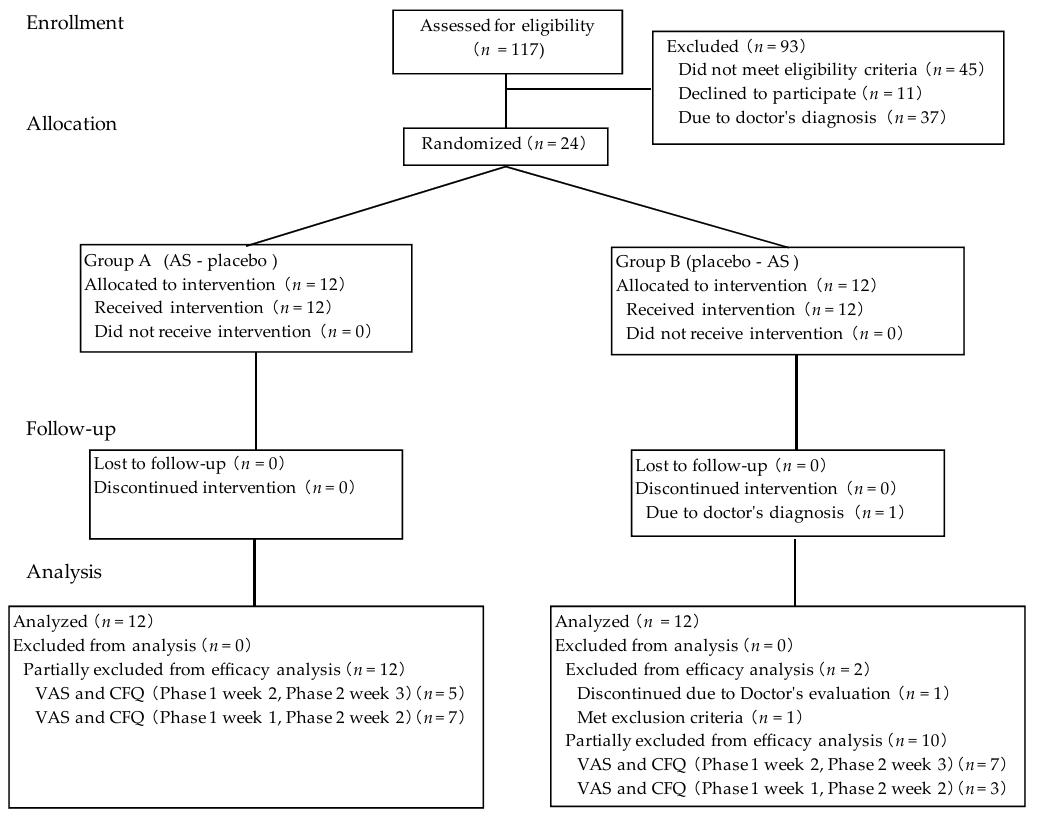
Figure 2. Flow diagram of participants. Table 1. Baseline characteristics 1 .